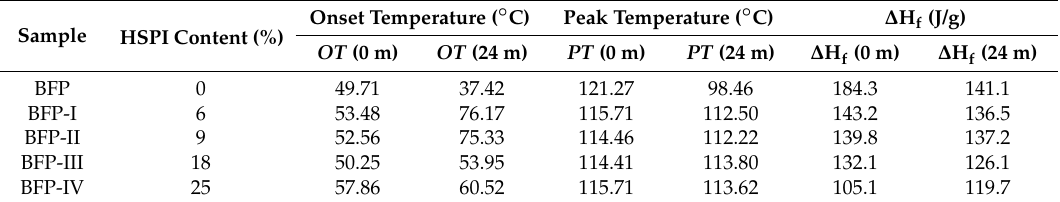
Table 2. Effect of HSPI and degradation time on crystallization behavior of the BFP, BFP-I, BFP-II, BFP-III, and BFP-IV materials.